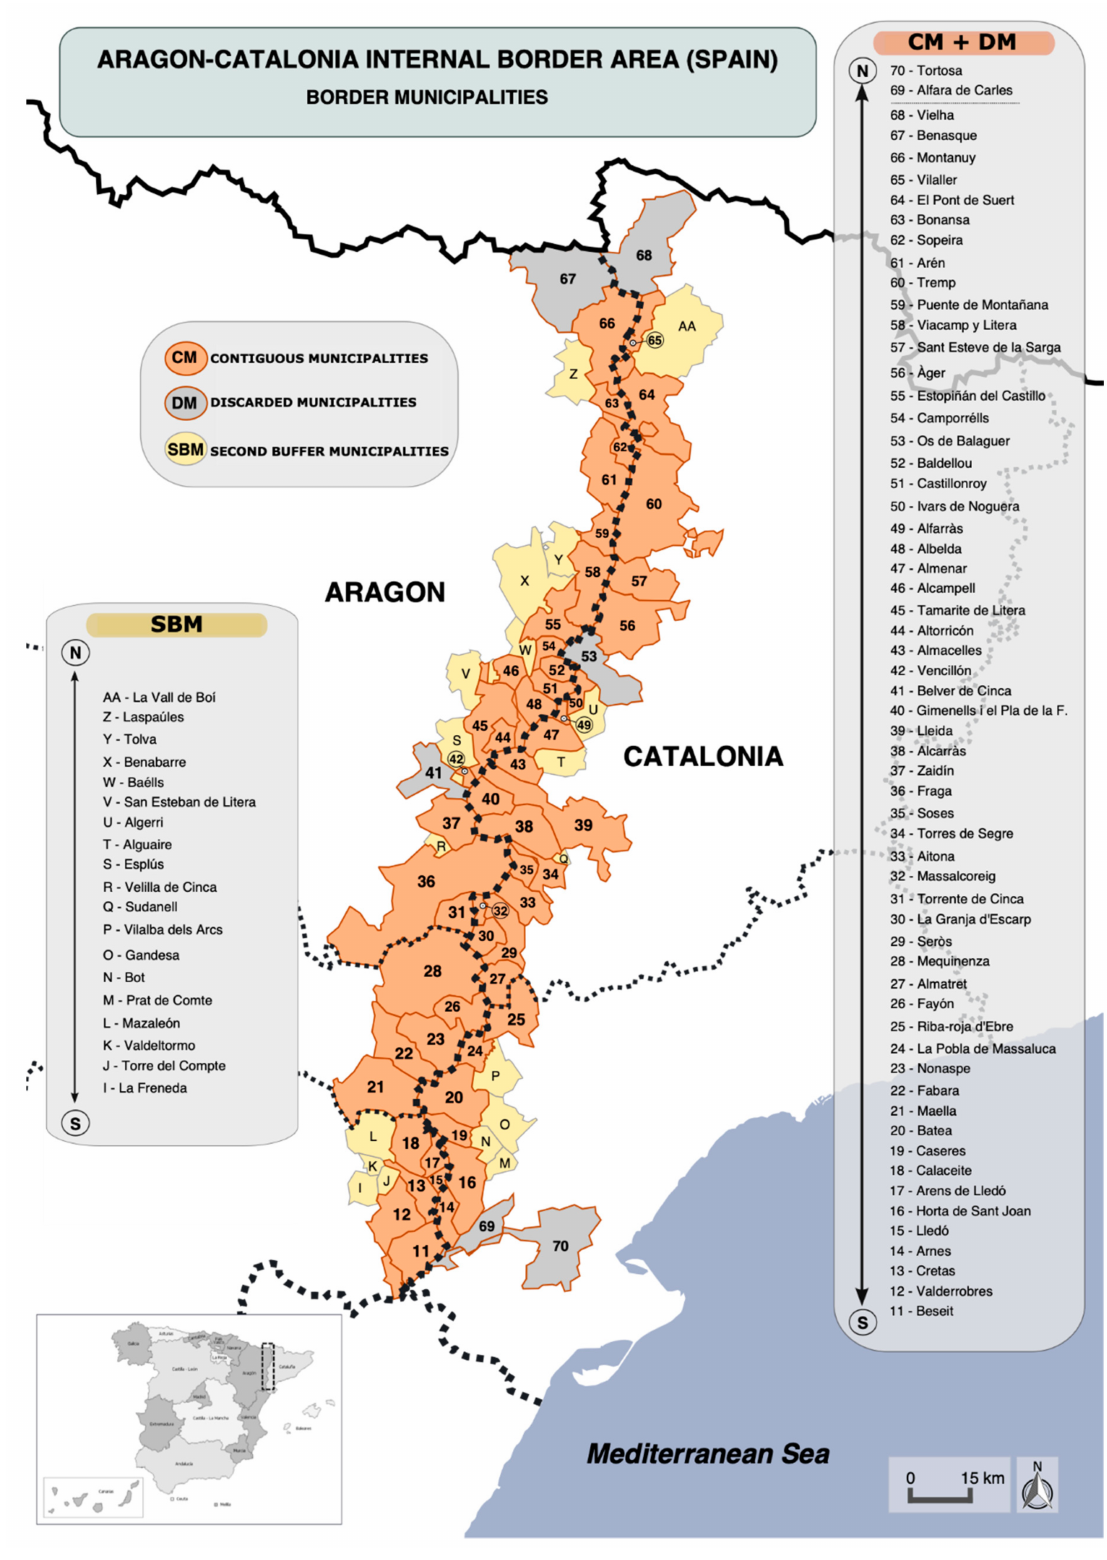
Figure 1. Border municipalities between Aragon and Catalonia (source: